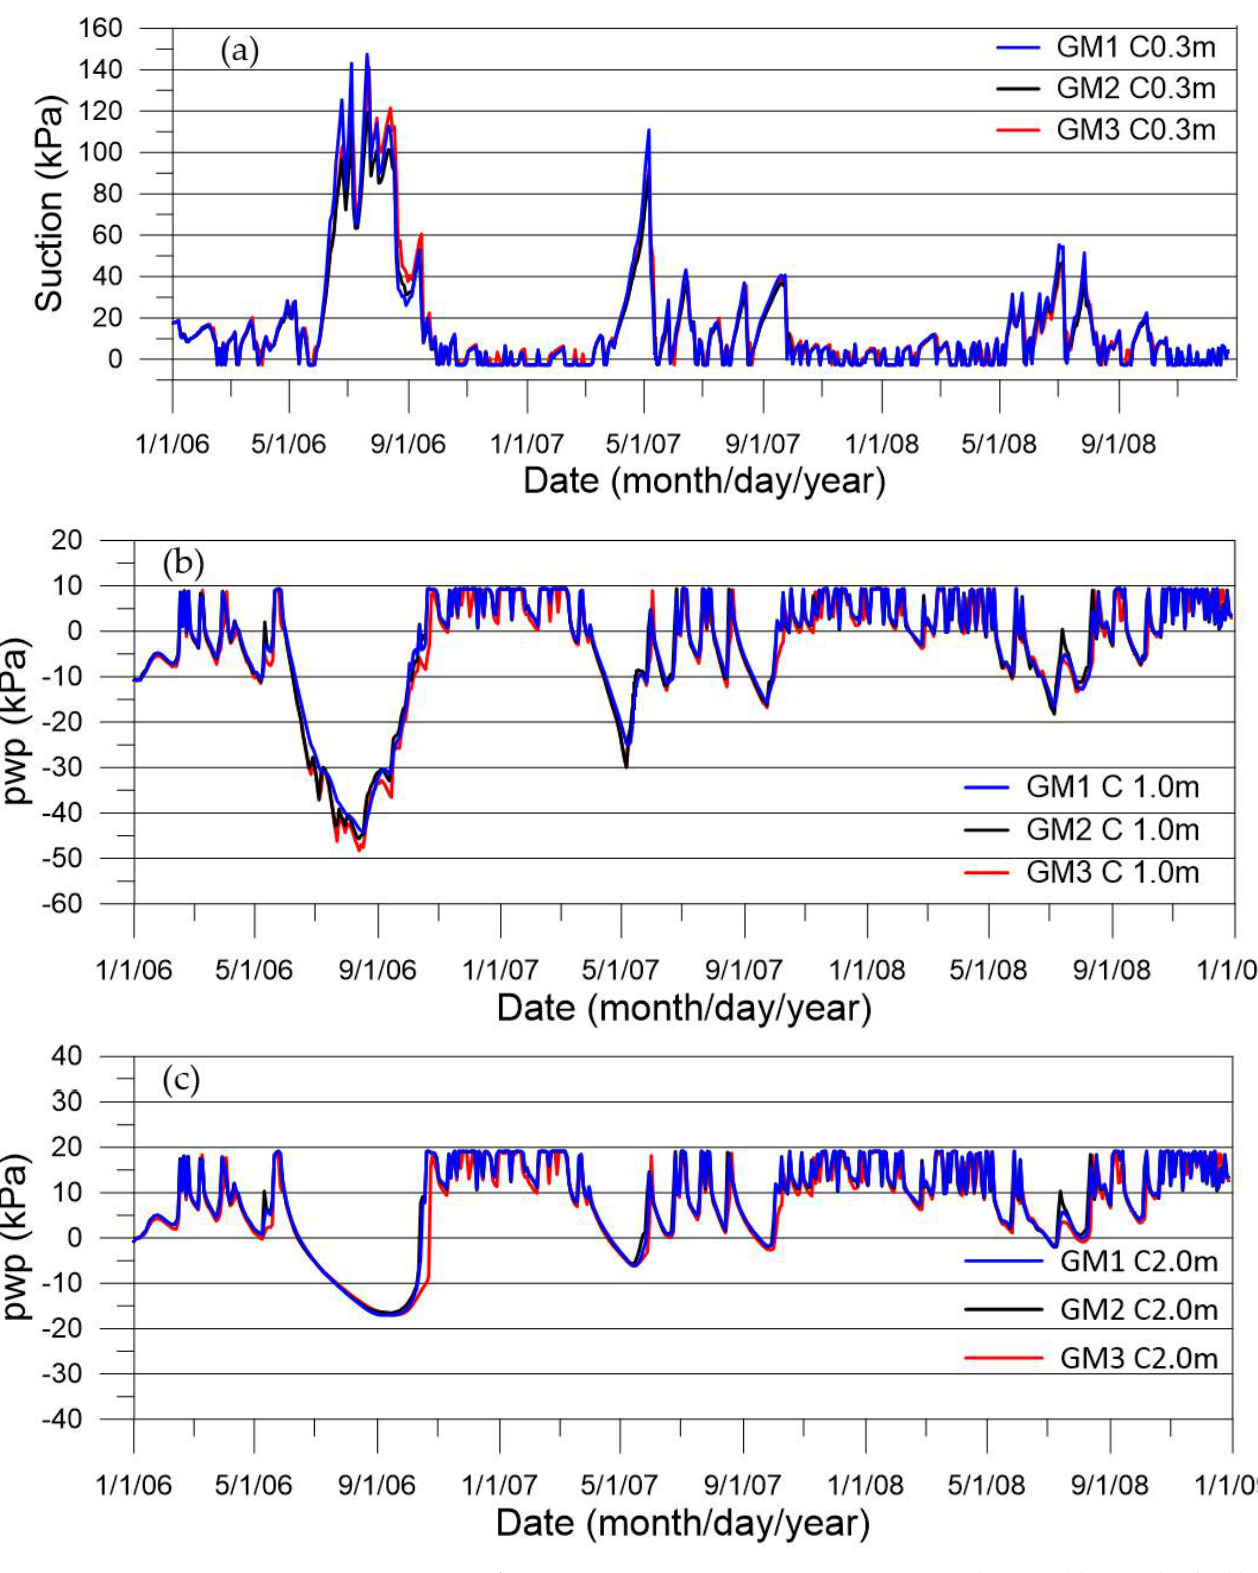
Figure A6. suction/pore water pressure response at instrumentation line C at ( a ) 0.3 m depth, ( b ) 1 m